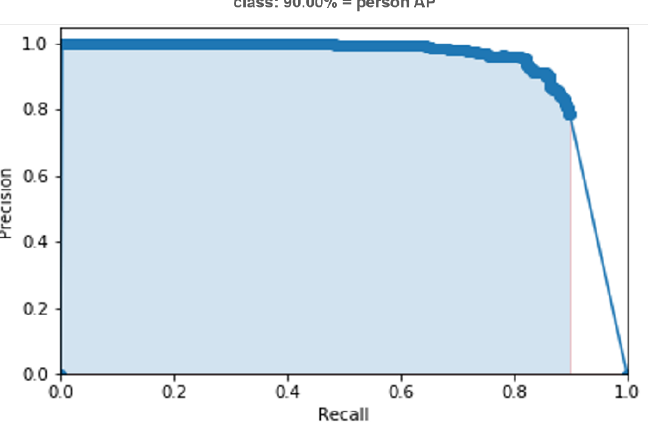
Figure 12. The AP score of PR curve for gait classifier trained on the DHU Night dataset.